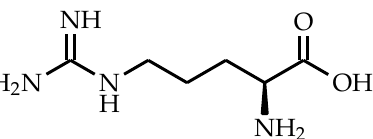
Figure 2. Chemical structure of L